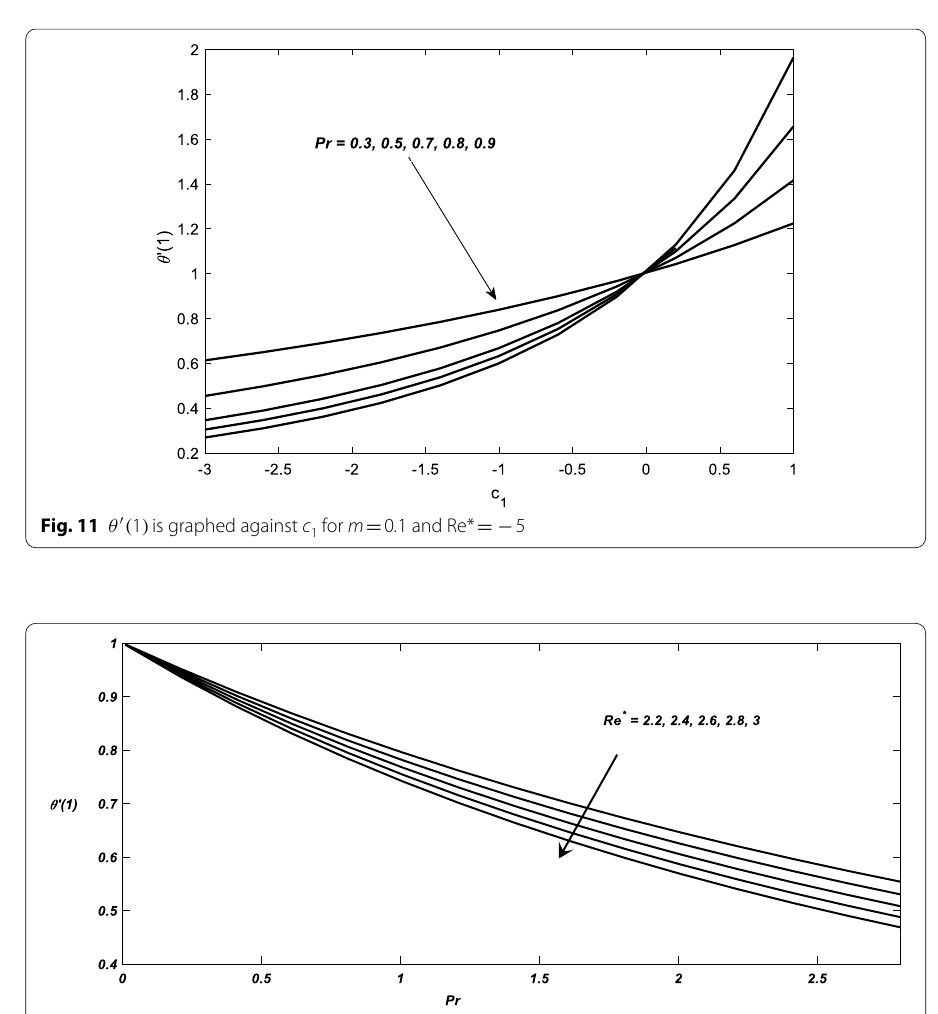
Fig. 12 Upper half of the channel and diverging flow: θ ′ ( 1 ) is graphed against Pr for m